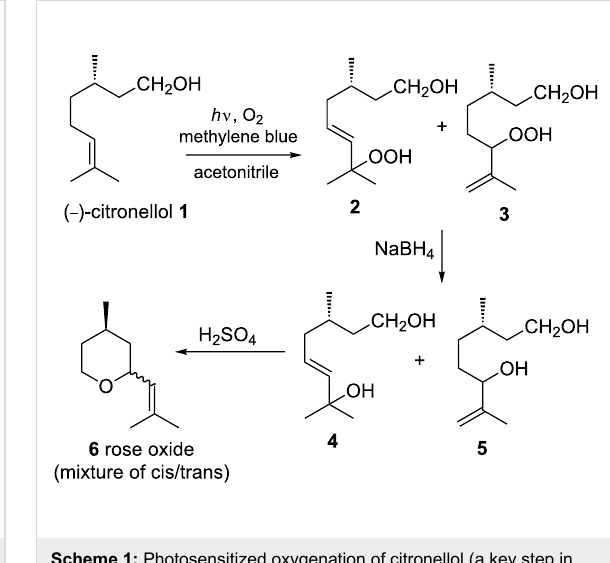
outer two channels were used for oxygen supply (Figure 3).